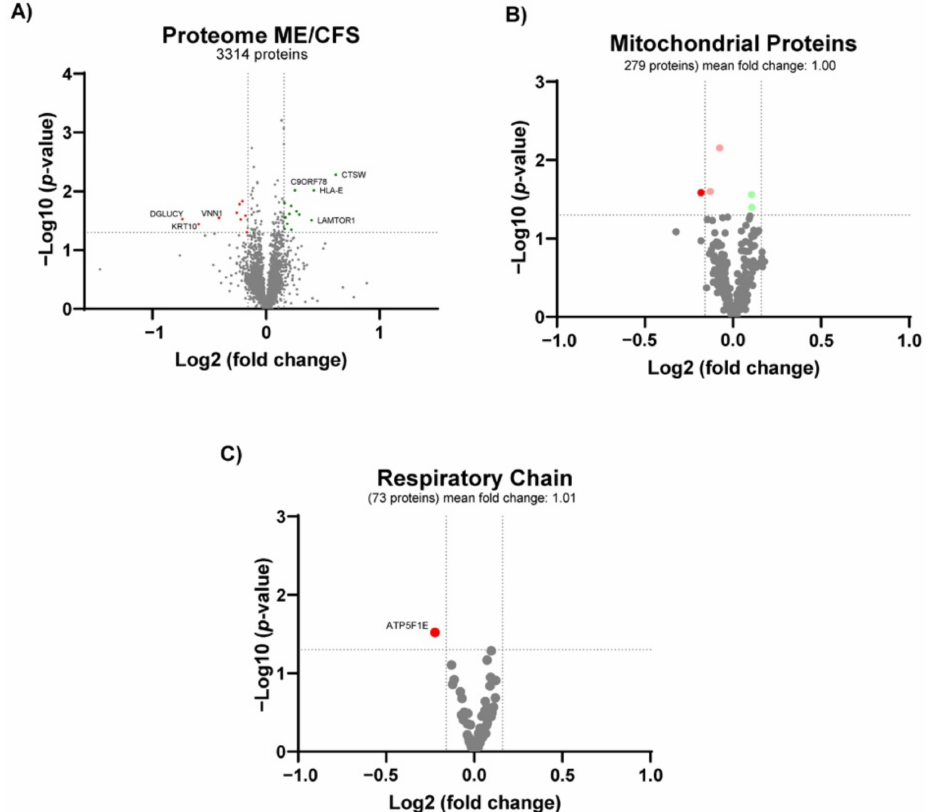
Figure 3. Proteomics profile of PBMCs from ME/CFS patients and healthy individuals as controls. Volcano plot of ( A ) all the quantified proteins, ( B ) the mitochondrial proteins and ( C ) respiratory chain proteins. n = 10 (4 controls, 6 ME/CFS patients). Red dots denote significantly lower proteins. Green dots denote significantly higher proteins. Light red and green dots denote significantly regulated proteins with a fold-change below the